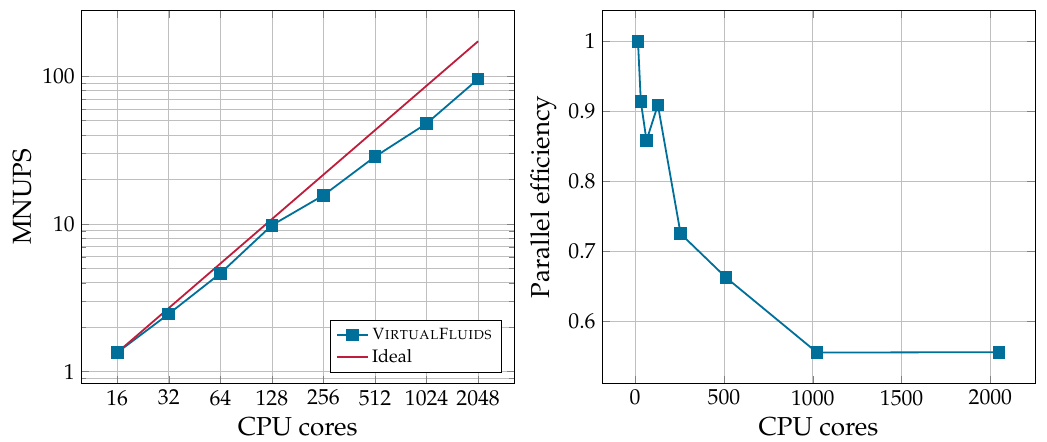
Figure 13. Parallel performance ( left ) and efficiency ( right ) of the FCM together with the VOF-PLIC in simulating the dissolution of calcium from a CT scan of an